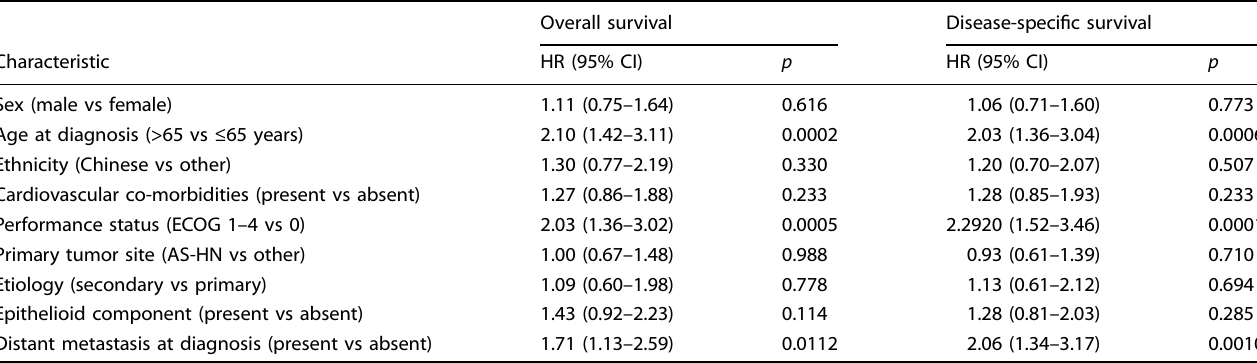
Table 3. Univariate survival analysis of the entire study cohort.